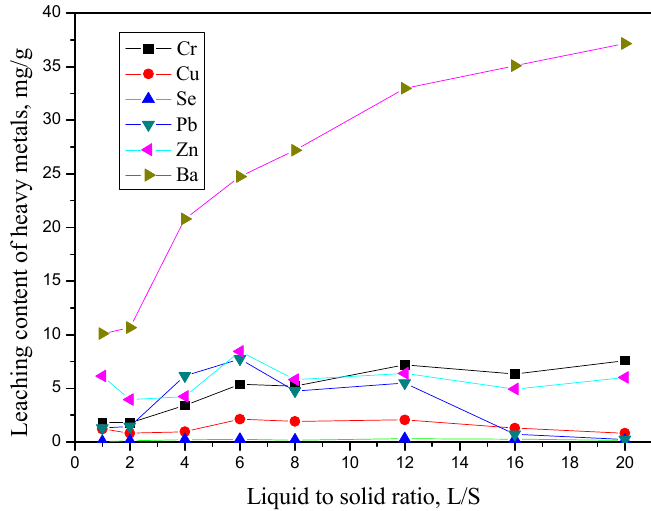
Figure 3. The evolution of the leaching content of heavy metals vs. L/S.